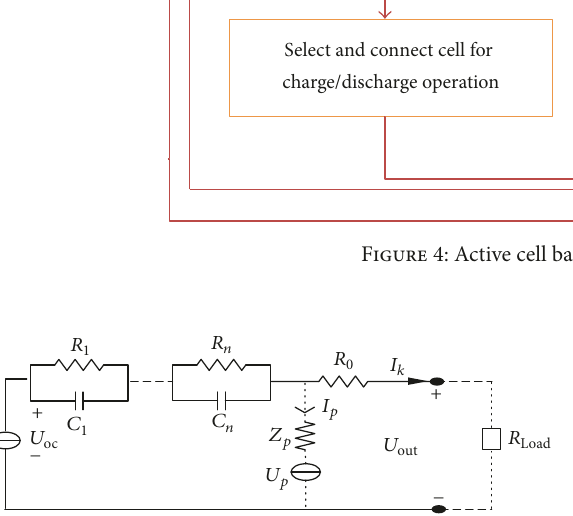
Figure 5: Classical topology of Thevenin equivalent circuit